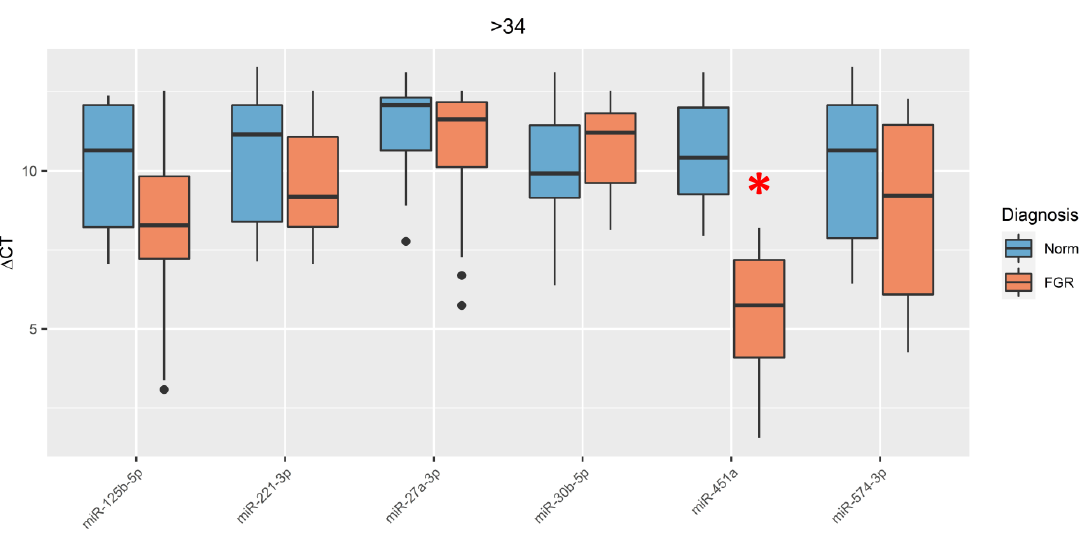
Figure 3. Comparative analysis of expression levels for miR-27a-3p, miR-30b-5p, miR-125b-5p, miR-221-3p, miR-451a, and miR-574-3p in umbilical cord blood plasma in pregnant women with late-onset FGR (FGR > 34). An asterisk marks significant di ff erences in the level of miRNA expression. The box diagram shows the medians of ∆ Ct values, the first and third quartiles, and the edges of the statistically significant sample, and the dots denote the emissions. The lower the value of ∆ Ct, the higher the level of expression of studied miRNA.